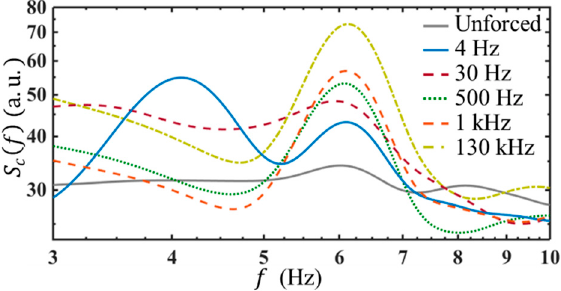
Figure 10. Peaks of temporal power spectra of concentration under E W = 2.74 × 10 4 V/m and different AC frequencies. Here, Q = 3 µ L/min. The electric conductivity ratio is 1:5250. Note, only at f f = 4 Hz, the applied E W = 6.15 × 10 3 V/m, to avoid electrolysis.